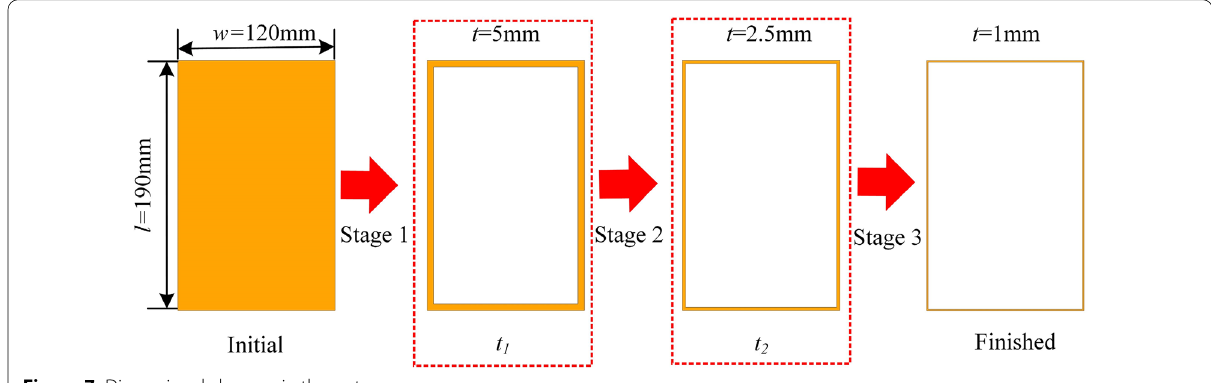
Figure 7 Dimensional changes in three stages